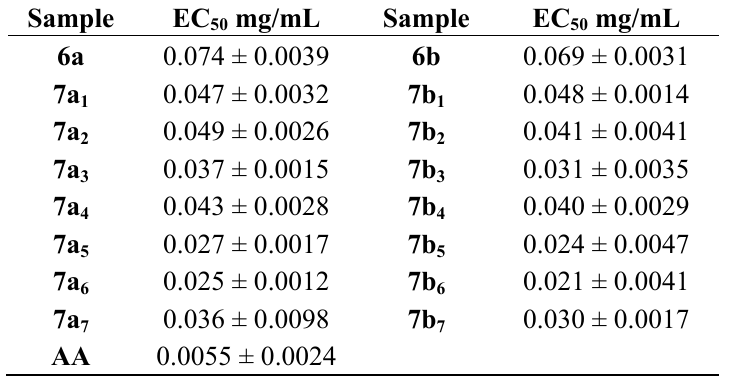
mg/mL) of the derivatives 6a , 6b , 7a 50